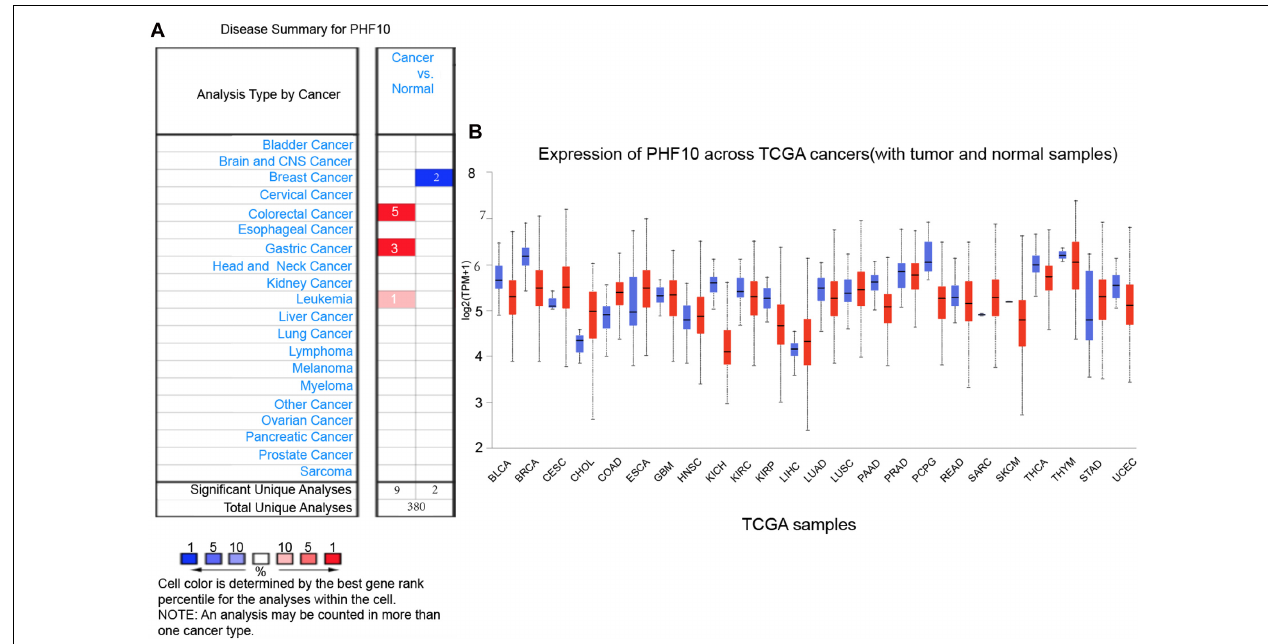
FIGURE 5 | PHF10 mRNA expression in different cancer types, (A) mRNA upregulation (Red), and downregulation (Blue) of PHF10 in different cancer types retrieved from the ONCOMINE database. The data were selected based on P -value: 1E-4, fold change: 2, and top 10% gene rank. PHF10 is upregulated in Gastric Cancer which is indicated in Red color. (B) Expression of PHF10 across various cancer TCGA Cancer data with tumor (red) and normal samples (Blue) depict as boxplots using UALCAN web that include the values between upper and lower quartile inside the box and dashed lines indicate the upper and lower limit of average expression.